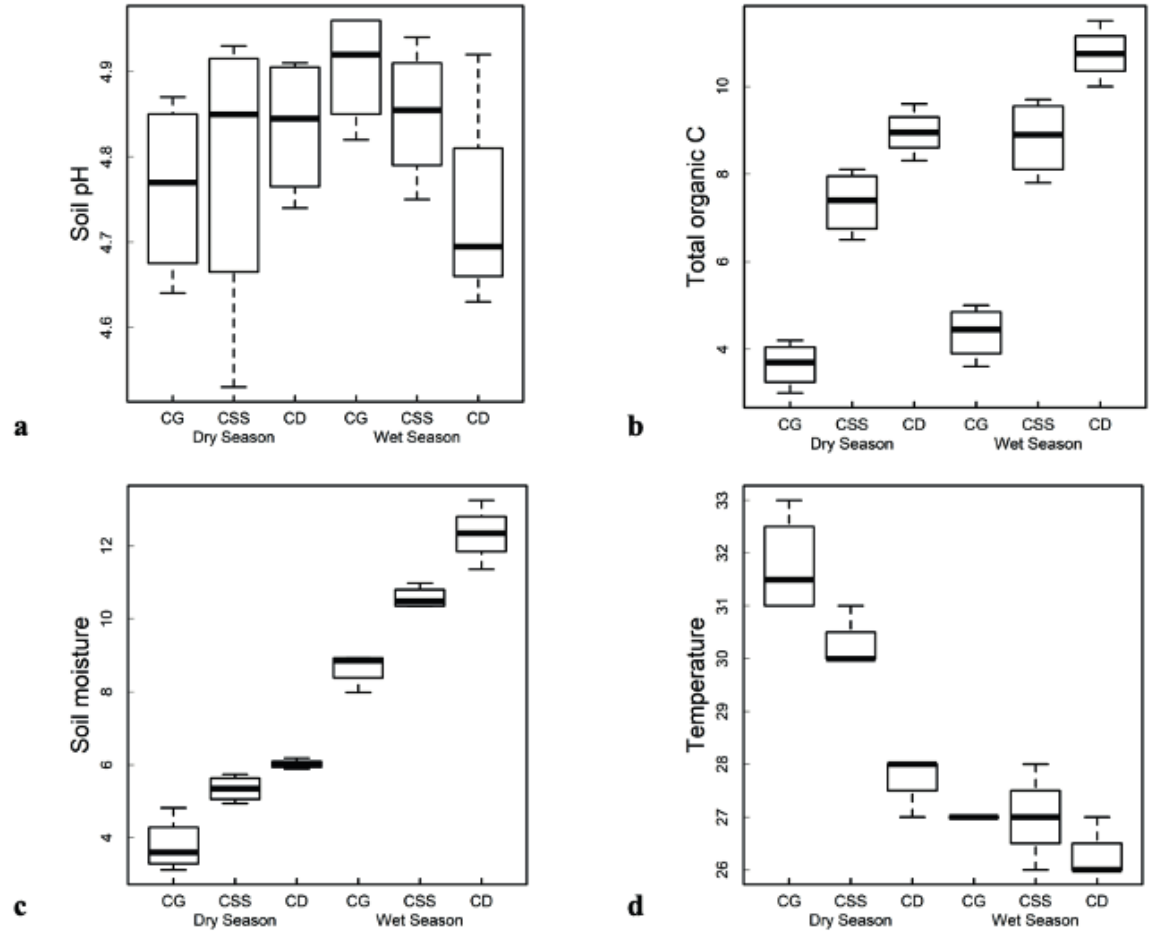
Figure 1. Drivers for ecosystem function between Cerrado physiognomies: Soil pH (a), total organic C (b), moisture (c), and temperature (d). Error bars represent the standard deviation of four independent